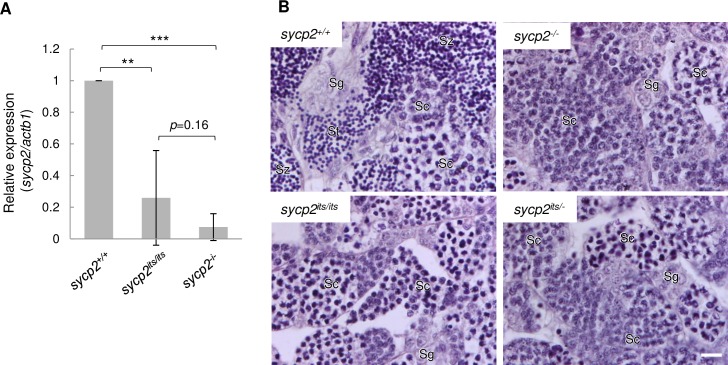
its mutant phenotypes are associated with the sycp2 gene.A: Expression of sycp2 mRNA in sycp2+/+, sycp2its/its and sycp2-/- testes. The mRNA levels relative to actb1 are shown (n = 5). The vertical bars indicate the SD. ** and *** indicate p<0.01 and p<0.001, respectively (Student’s t-test). B: HE-stained sections of sycp2+/+, sycp2-/-, sycp2its/its, and sycp2its/- testes. All samples were prepared from the same siblings. Sg: spermatogonia, Sc: spermatocytes, St: spermatids, Sz: spermatozoa. Spermatids and spermatozoa were observed only on the sycp2+/+ section. Scale bar, 10 μm.